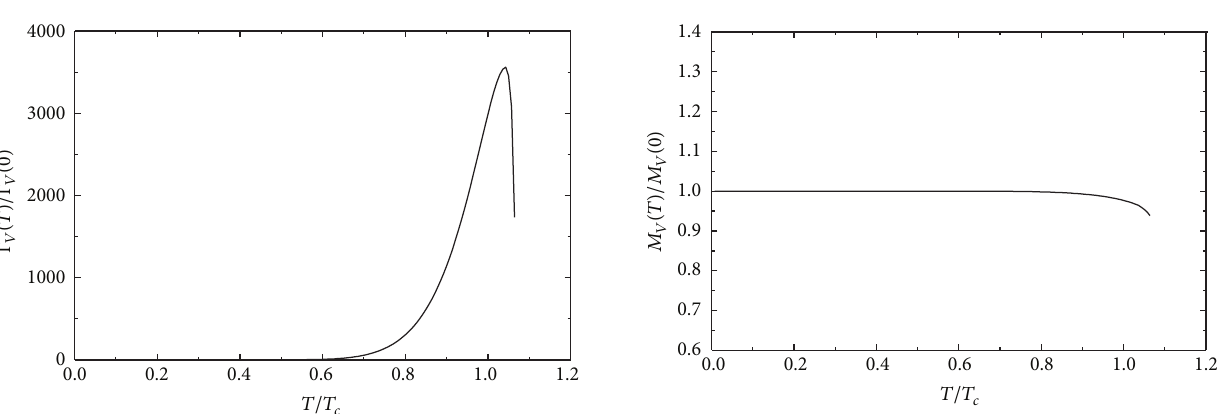
Figure 20: The ratio Γ 𝑉 (𝑇)/Γ 𝑉 (0) as a function of 𝑇/𝑇 𝑐 for 𝐽/𝜓 channel, from thermal Hilbert moment QCD sum rules.